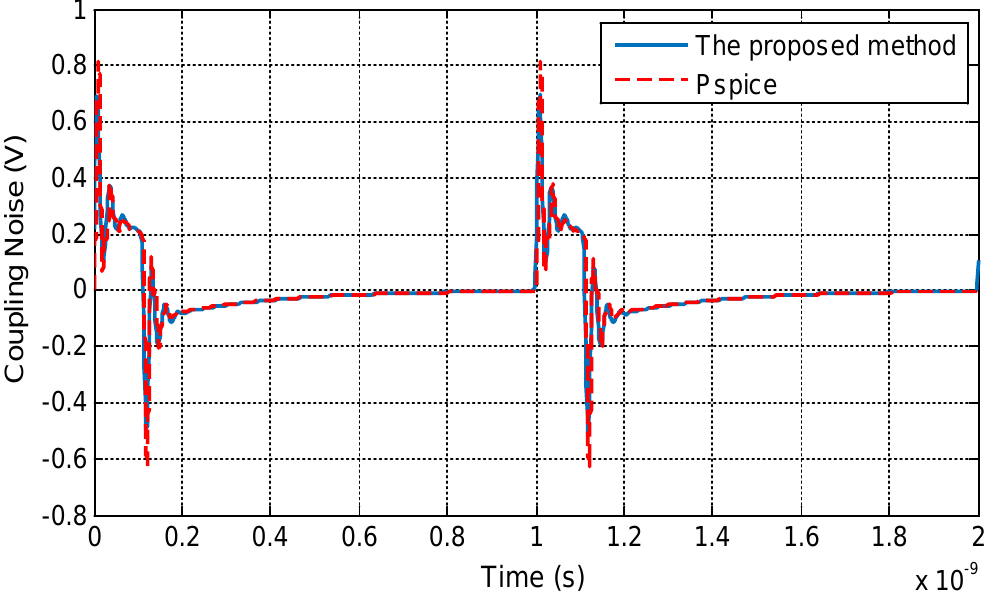
Figure 18. The proposed method and Pspice simulation of the TSV–TSV coupling noise with coupled RDLs ( l RDL = 500 µm and t r = 10 ps) at port 4.